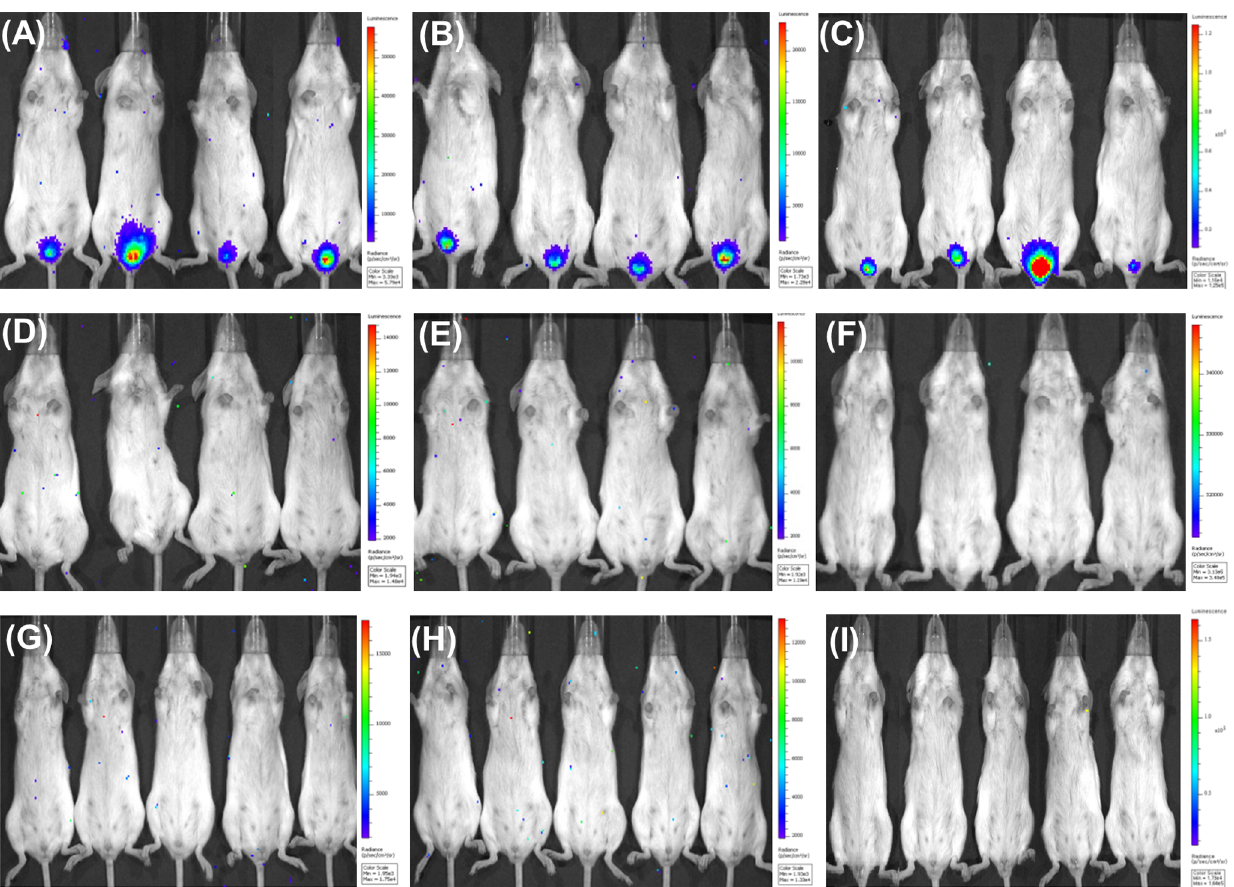
Figure 8. HPV challenge test with HPV pesudovirions in AcHERV-HPL1s immunized mice. Mice were immunized three times with PBS (A, B, C), AcHERV-HP16L1 (D), AcHERV-HP18L1 (E), AcHERV-HP58L1 (F), AcHERV-HP16/18L1 (G), AcHERV-HP18/16L1 (H), and AcHERV-HP16/18/58L1 (I) over 6 weeks. Ten weeks after the first immunization, mice received vaginal challenge with PV16 (A, D), PV18 (B, E), PV58 (C, F), the mixture of PV16 and PV18 (G, H), or with the mixture of PV16, PV18, and PV58 (I). Three days after challenge, mice were anesthetized, injected with luciferin, and the levels of luminescence were detected with an IVIS 200 bioluminescence imaging system.